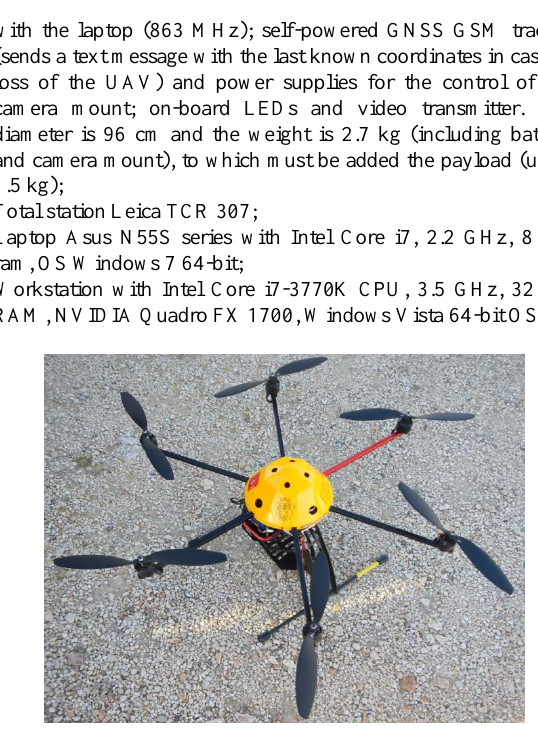
Figure 1. MikroKopter